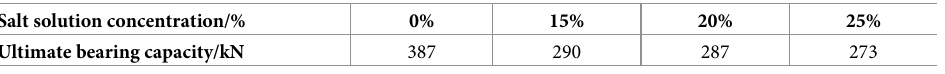
Table 7. Axial compressive ultimate bearing capacity of specimens with different concentrations of salt